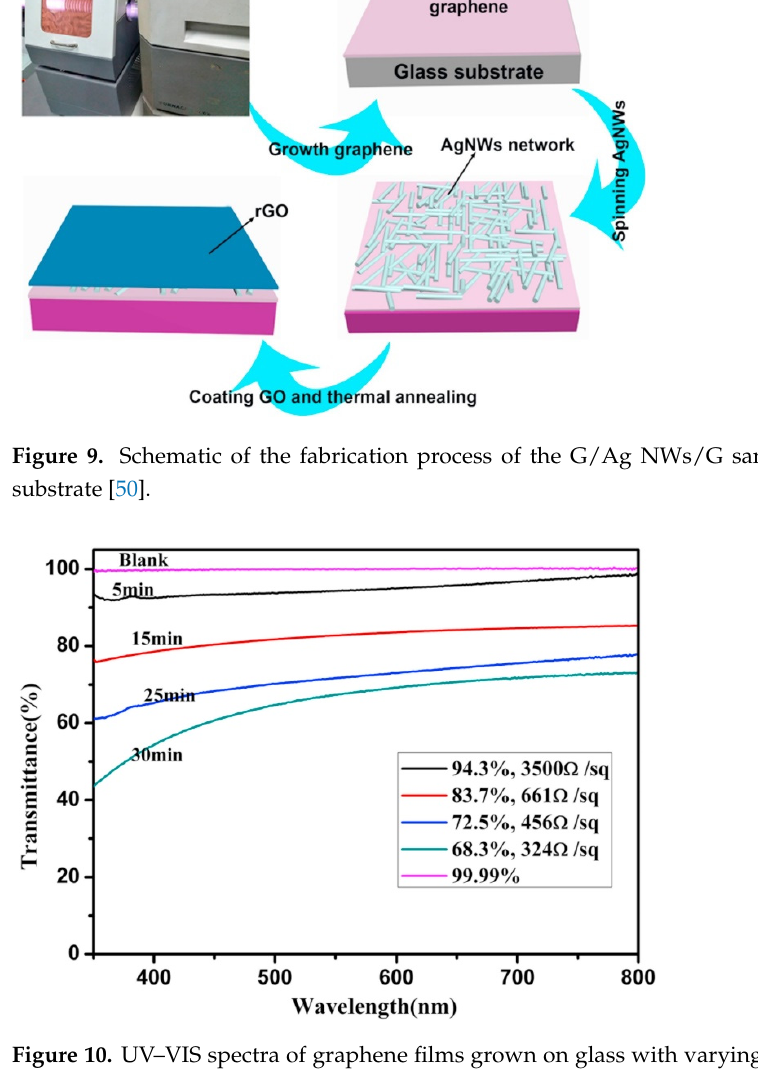
Figure 11. Changes of sheet resistance of G/AgNWs/G/glass and AgNWs/G/glass after exposure to air at 95 °C for 24, 48, and 72 h [50]. The original figure is from reference [50], figure 11 (a). The films prepared in these three works in this section all perform well, with both low sheet resistance and high light transmission. The pure graphene electrode used in the first study has excellent light transmission and mechanical properties. The second group has a thin thickness comparable to that of electrodes using layered metals. The third group combines the advantages of graphene and metal nanowires; although slightly lower in light transmittance, the sheet resistance in this study is to the most closed to that of the metal layer electrodes. Graphene-containing transparent conductive films are full of potential. As a focus of research in recent years, graphene is indispensable in the field of trans- parent electrodes. While the sheet resistance of graphene is not ideal when it is used alone, its comprehensive performance can be enhanced when combined with metals. For example, the mechanical properties of graphene enable it to provide good protection for the nanostructures within the coating, and further enhancing the mechanical properties of the electrode can meet the needs of gradually developing flexible electronic devices. There is still considerable room for the development of graphene in this field with huge application prospects. Combining graphene with other structures discussed in this review might lead to the development of new electrodes with amazing performance, which is a topic worthy of further research and development.